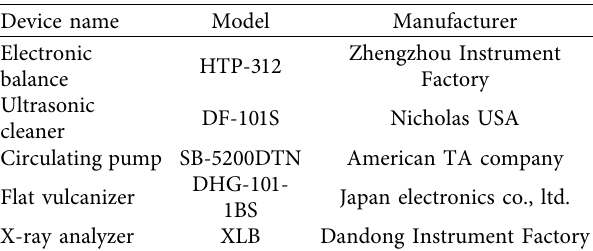
Figure 2: Schematic diagram of the synthesis and preparation of multifunctional materials. Table 1: Laboratory